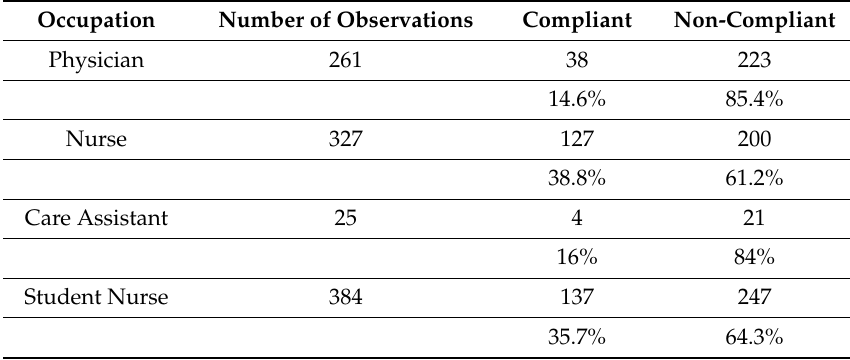
Table 3. Hand hygiene compliance of healthcare workers from direct